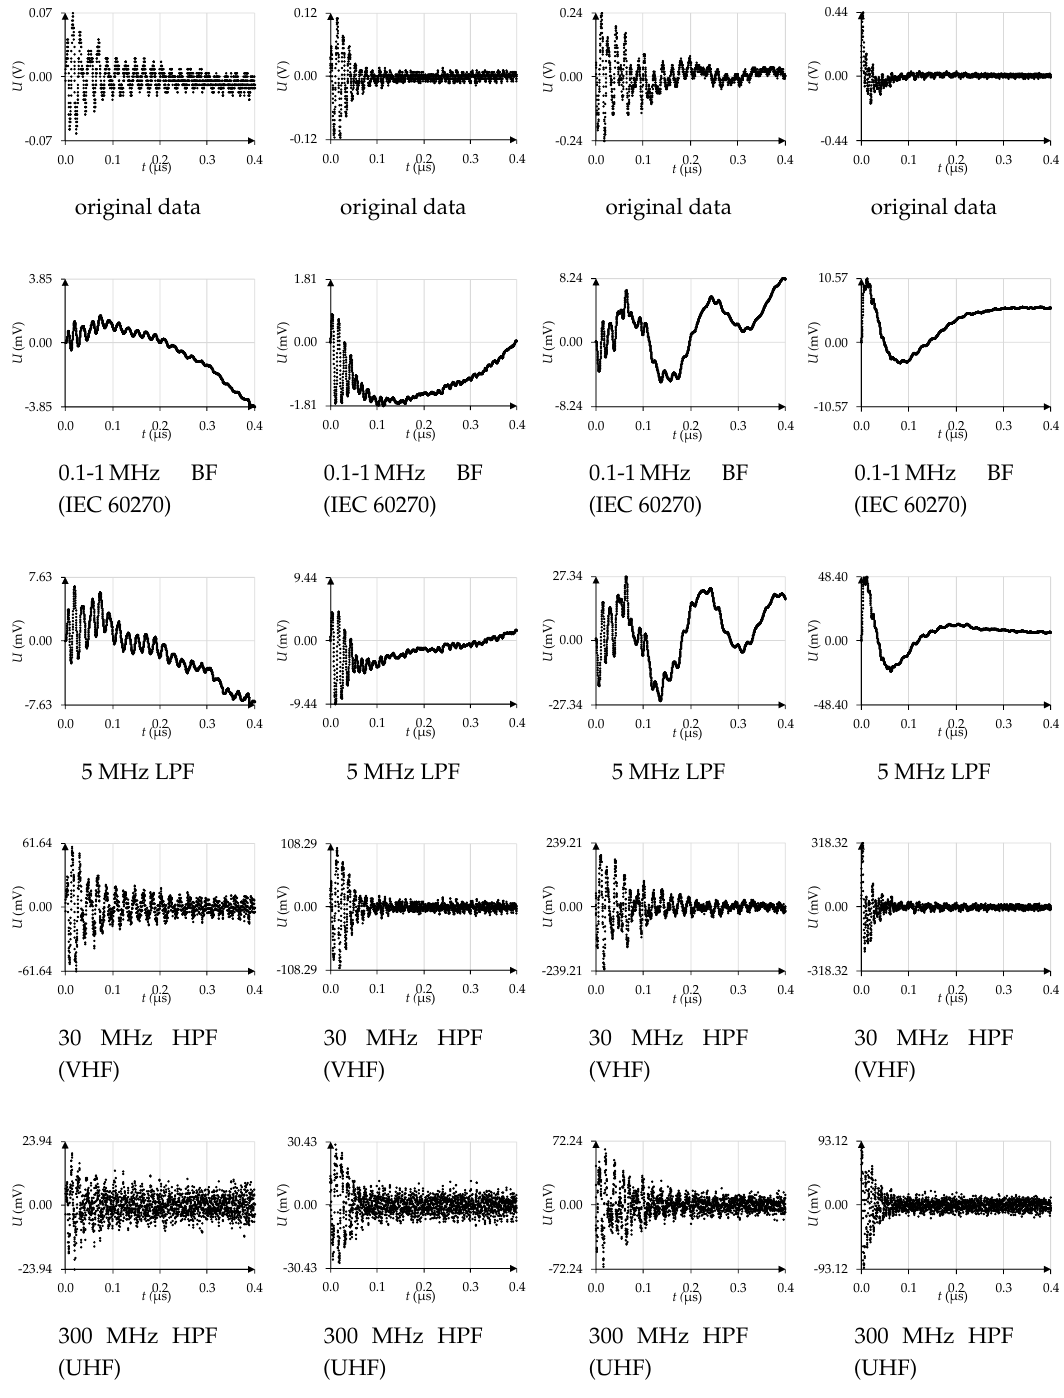
Figure 8. From left to right: PD on monopole antenna, disturbance on monopole antenna, displacement current shunt, PD